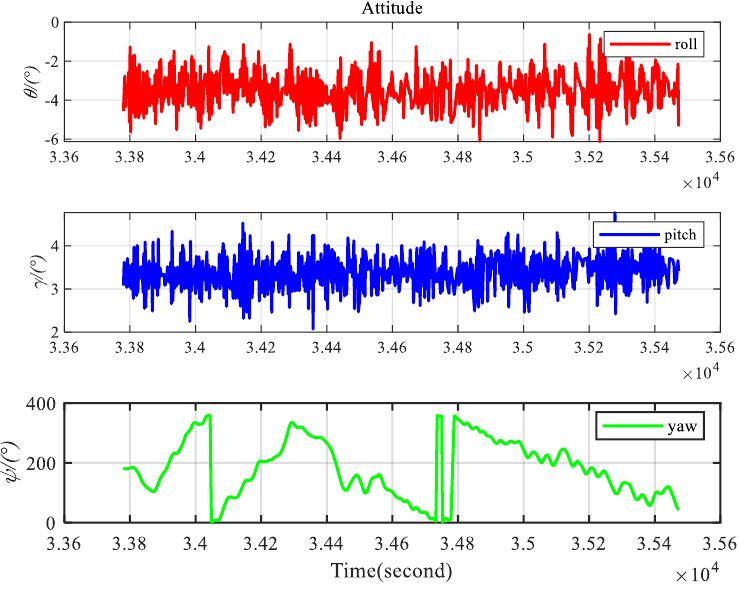
Figure 6. Changes of the three attitude angles.